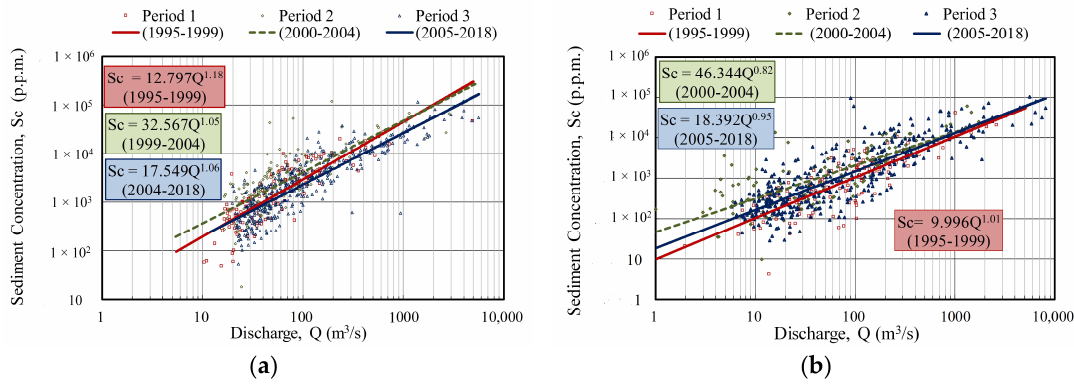
Figure 4. The variation of measured suspended sediment discharge rating curve for pre-1999 earthquake period (period 1, 1995–1999), post-1999 earthquake period (period 2, 2000–2004), and exposed-bedrock period (period 3, 2005–2018): ( a ) Upstream suspended sediment rating curve, 5 km upstream of the study reach, Yu-Fong Bridge (Station No. WRA1510H063); ( b ) Downstream suspended sediment rating curve, immediately downstream of the study reach, Chang-Yuan Bridge (Station No. WRA1510H057).